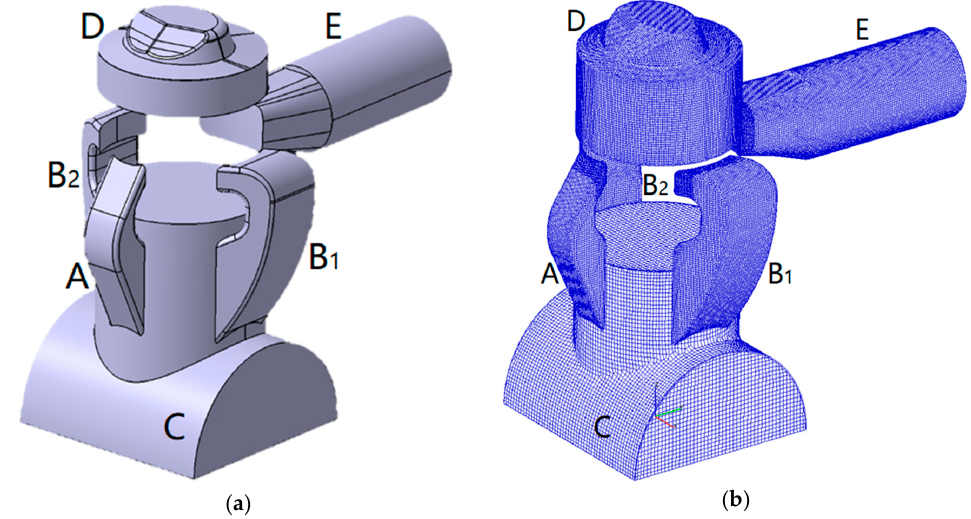
Figure 7. Scavenging system model. ( a ) CAD model; ( b ) CFD calculation model.